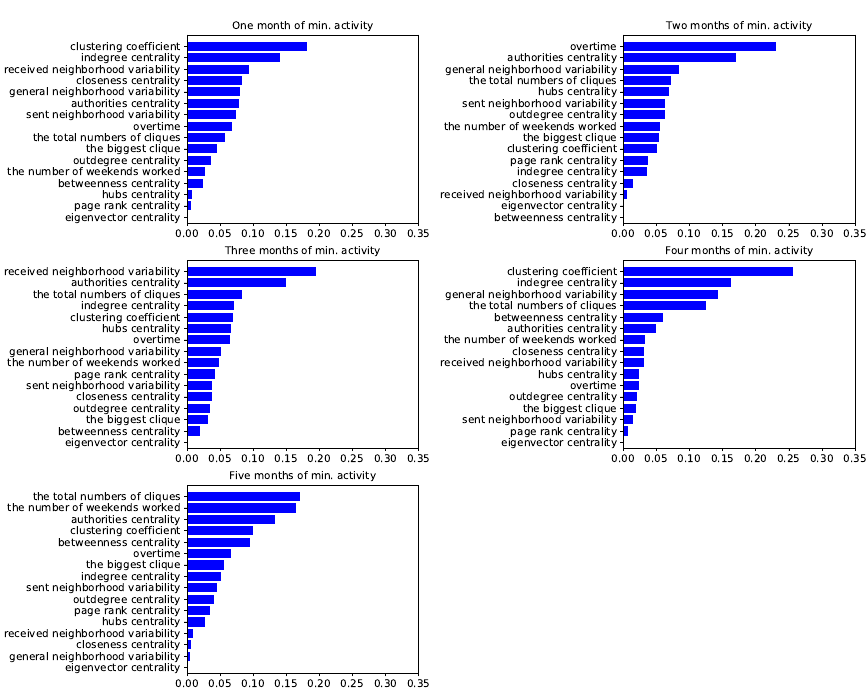
Figure A2. Features importance (Gini importance) for the Decision Tree which uses the full set of features for the manufacturing company dataset with three levels of the